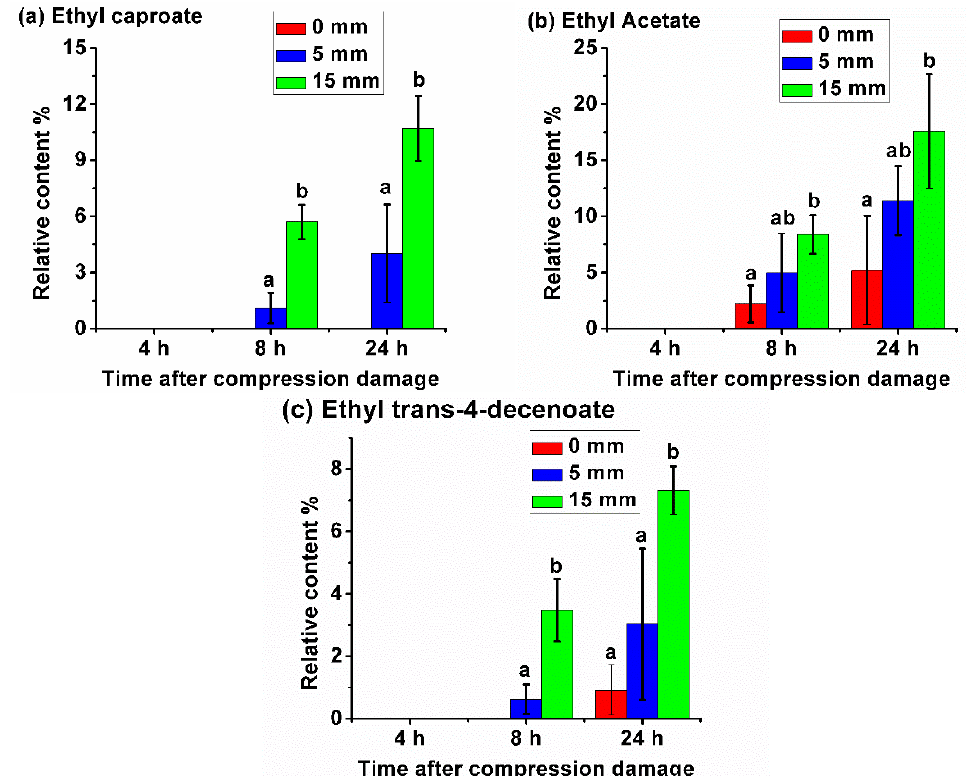
Figure 3. ( a – c ) Relative content of three VOCs increased with the increase of the level of compression